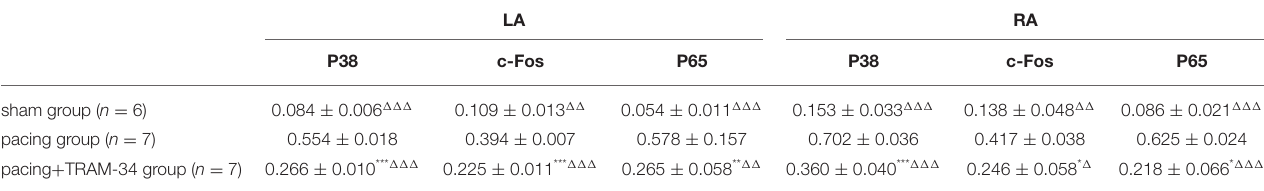
TABLE 3 | Levels of signaling pathway protein in atrial tissue.